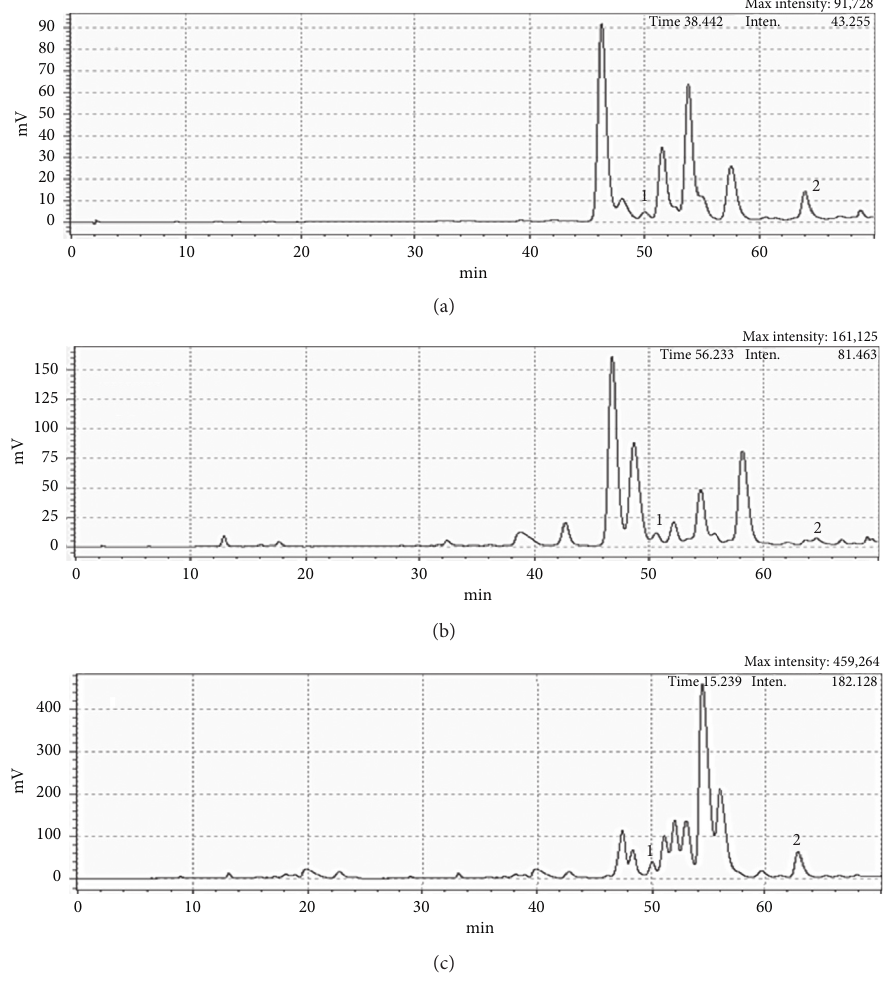
Figure 7: Chromatogram of different M. domestica sample at 374nm (a) peel, (b) leaf, and (c) stem bark; 1: rutin and 2: